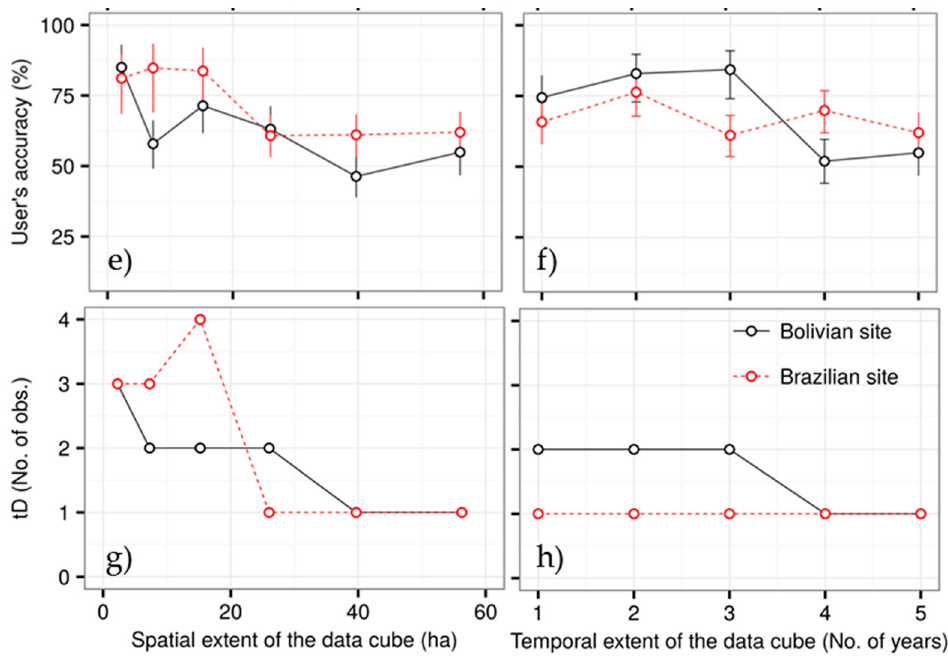
Figure 8. Overall accuracy ( a , b ); producer’s accuracy ( c , d ); user’s accuracy ( e , f ); and median temporal detection delay (tD) ( g , h ) of deforestation events at the Bolivian and Brazilian study sites as a function of the spatial ( left ) and temporal extent ( right ) of the local data cube. Vertical bars ( a – f ) indicate 95% confidence intervals. The effect of the spatial extent on spatial and temporal accuracy (Figure 8a,c,e,g), is shown for the results obtained from the longest temporal extent (TE = 5 years). The effect of the temporal extent is shown for the results obtained from the largest spatial extent (56.25 ha, Figure 8b,d,f,h).